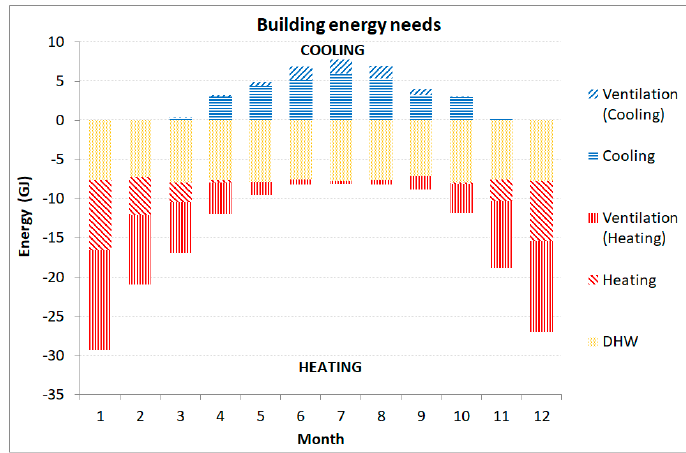
Figure 7. Monthly energy needs in terms of heating, cooling, ventilation (hot and cold coils of air handling units (AHU)), and domestic hot water (DHW).